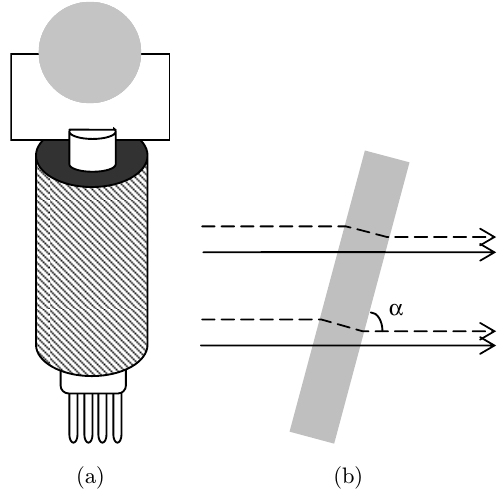
Fig. 9. (a) Glass plate mounted on a galvanometer, inter- secting half of the excitation beam whose cross section is indi- cated by the gray circle. (b) Beams passing (solid lines) or by passing (dashed lines) the glass plate have an optical path length di®erence that is tilting angle dependent.